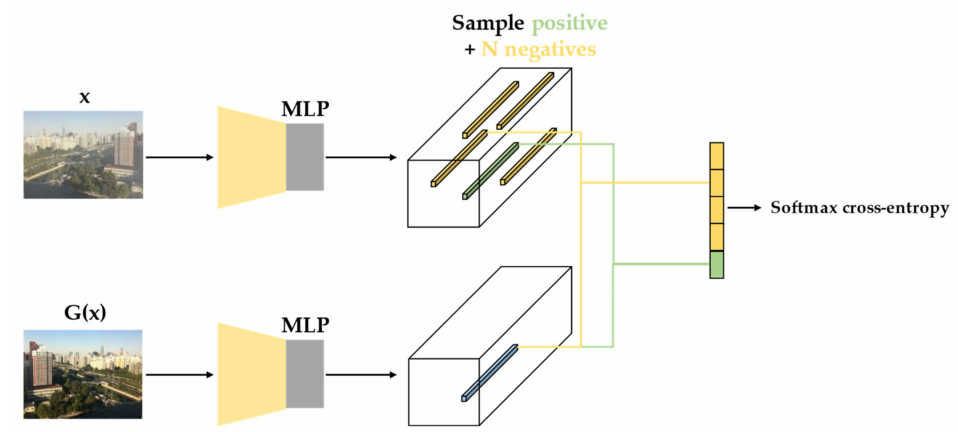
Figure 7. Patch-wise contrastive